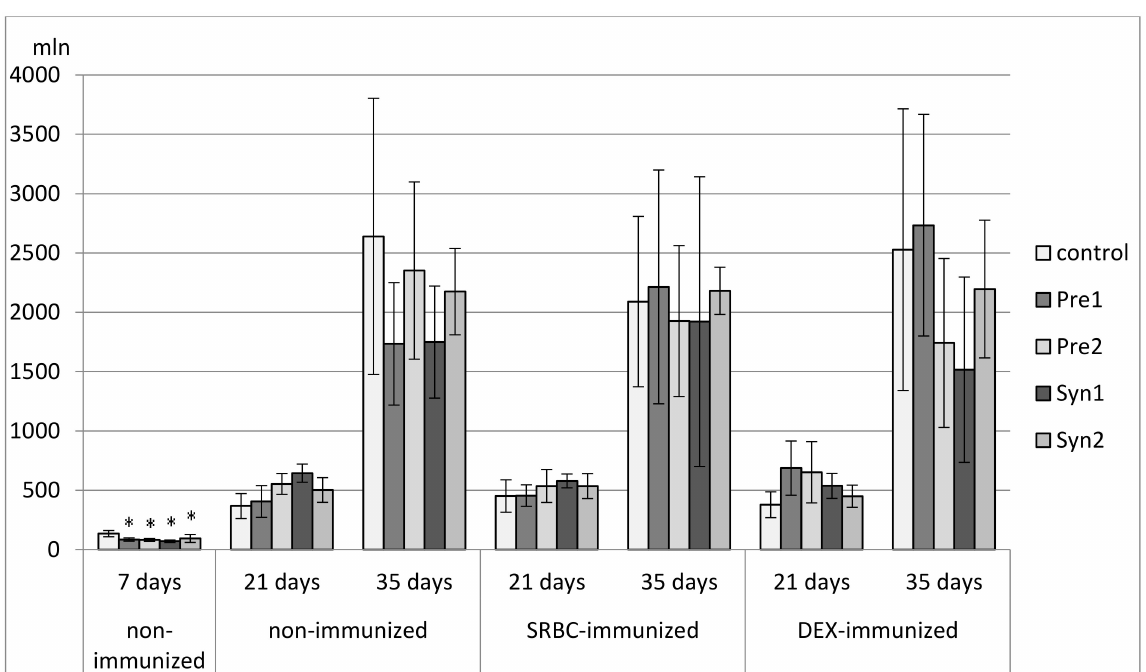
Figure 9. The total count of CD3 + cells in the spleen of chicken broilers after in ovo injection of the investigated prebiotics or synbiotics. The data are expressed as the mean ± SD. Data with a symbol (*) denote a significant difference with respect to the control group ( p < 0.05).